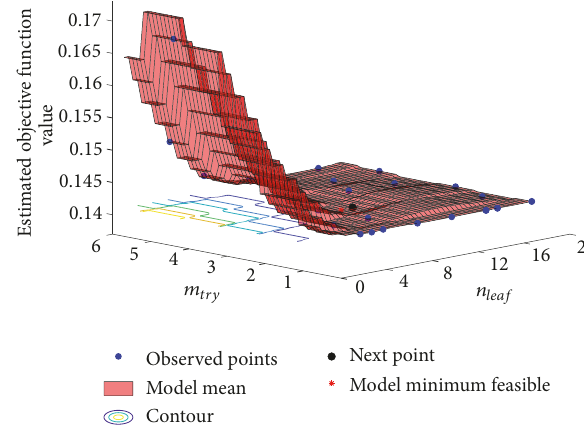
Figure 4: The objective function model.